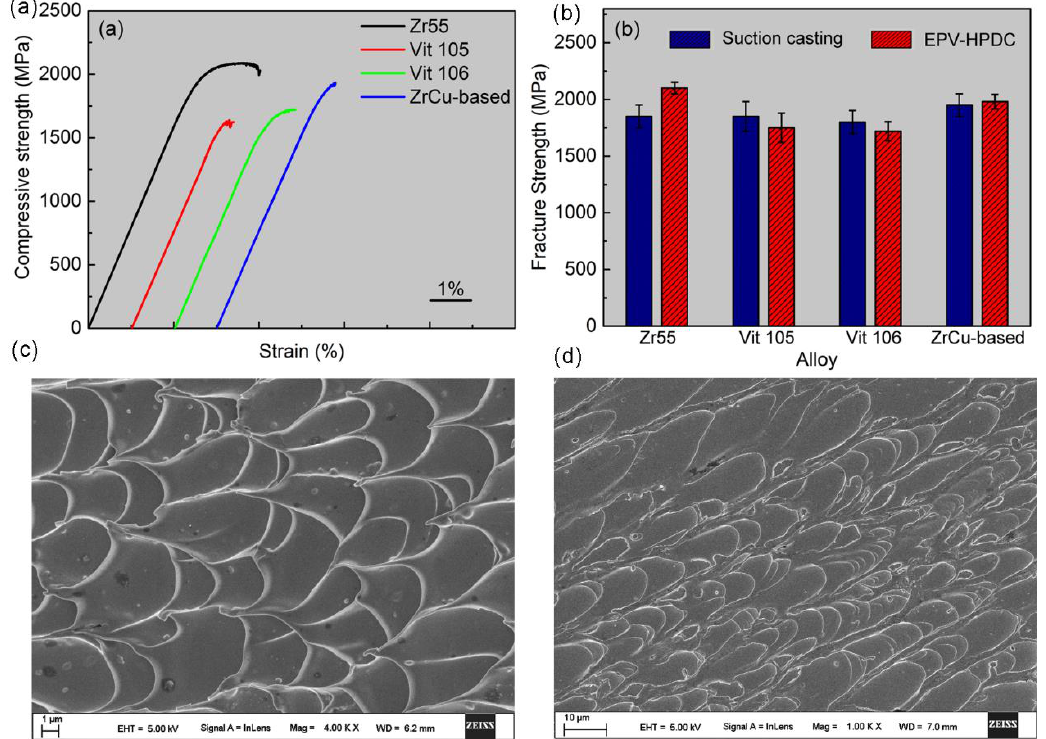
Figure 4. ( a ) Engineering stress–strain curves for the Zr 55 Cu 30 Ni 5 Al 10 (Zr55), Zr 52.5 Ti 5 Cu 17.9 Ni 14.6 Al 10 (Vit105), Zr 57 Nb 5 Cu 15.4 Ni 12.6 Al 10 (Vit106), and Zr 46.5 Cu 47.5 Al 4 Co 1 Sn 1 (ZrCu-based) BMG samples,